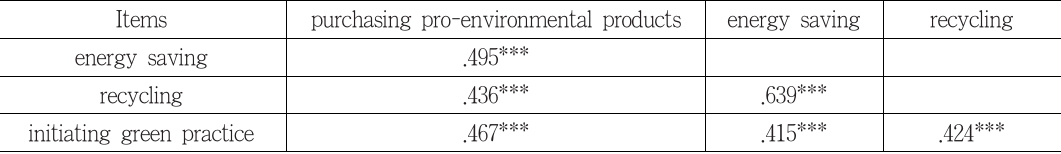
<Table 1> Correlations among Practices for Green Behavioral